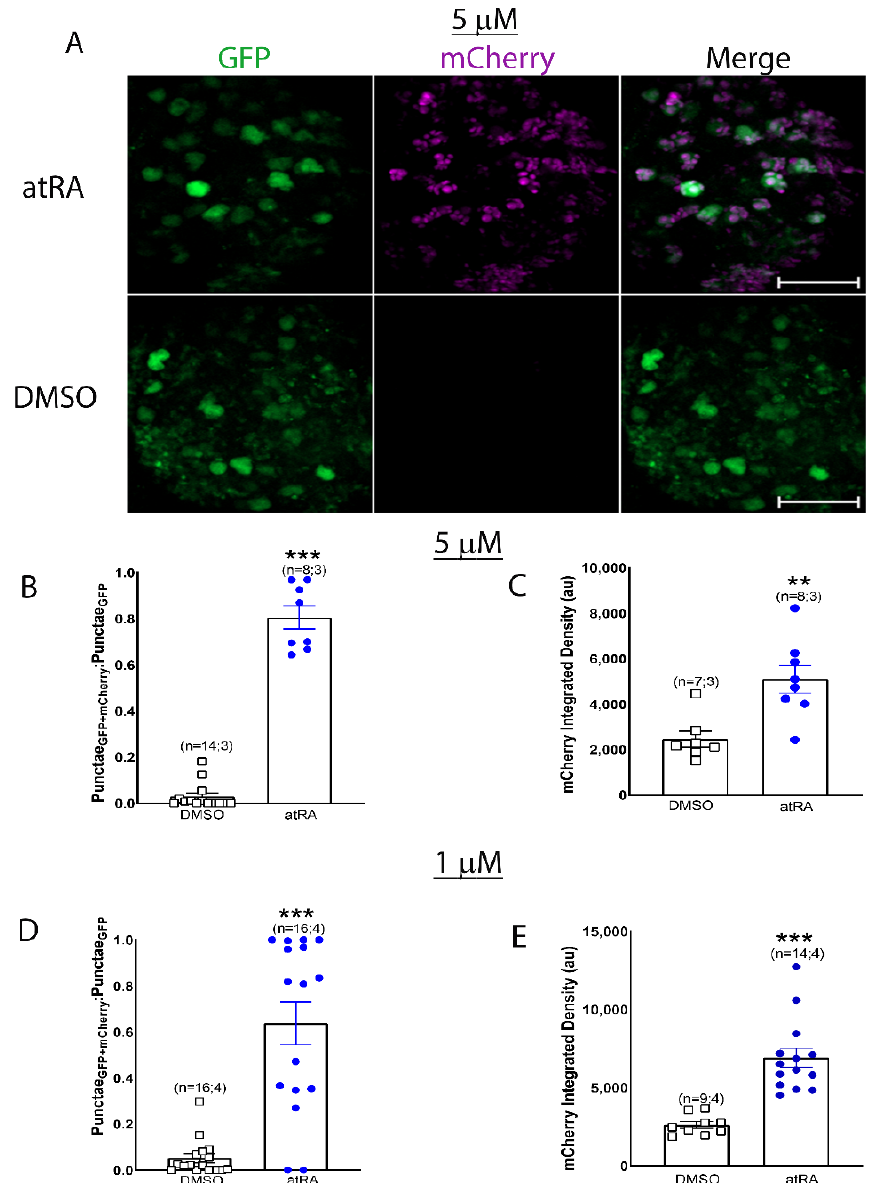
Figure 4. Lower concentrations of both 5 μ M and 1 μ M all- trans RA significantly enhance transcrip- tional activity of the sensor. ( A ) Representative images of sensor activation and transcriptional activity in CNS hemispheres by 5 μ M all- trans RA (atRA), but not by 0.05% DMSO, following heat-shock. ( B , D ) Quantitative analysis indicates a significantly higher proportion of GFP punctae also containing mCherry following exposure to both 5 μ M atRA ( B ) and 1 μ M atRA ( D ) and a significantly higher mCherry integrated density following exposure to both 5 μ M atRA ( C ) and 1 μ M atRA ( E ). ** p < 0.01; *** p < 0.001, compared to DMSO. Numbers in brackets represent the total number of CNS and number of separate trials. Scale bars: 50 μ m.